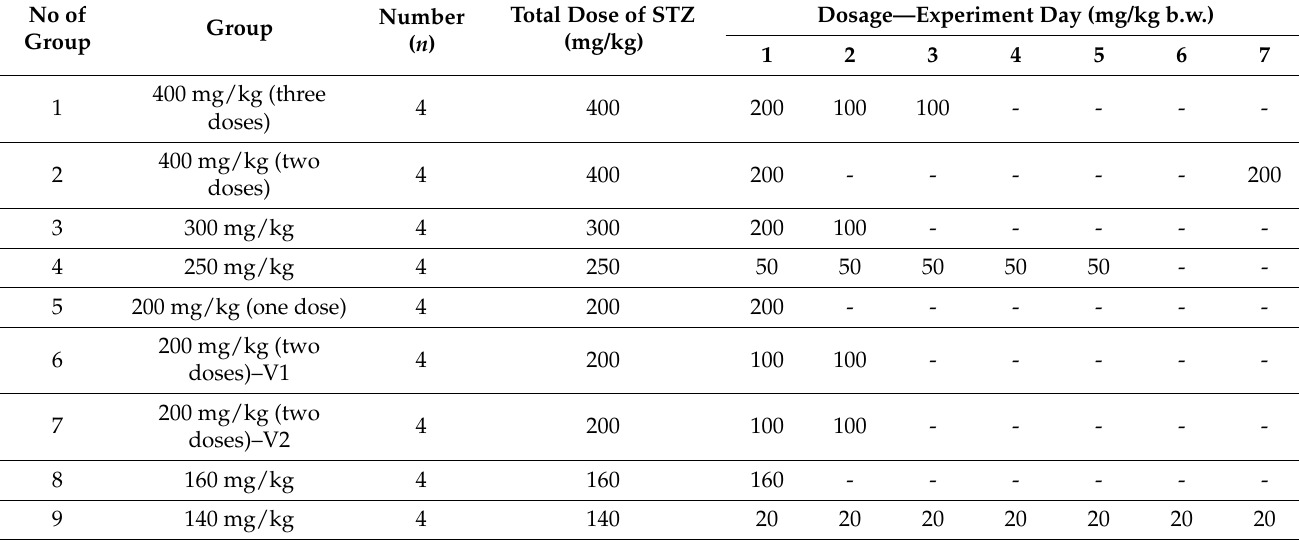
Figure 3. Experimental protocol. The entire experiment was divided into three stages of research. Step 1—assessment of the general health of the animals (bodyweight measurement/C-peptide blood sampling/blood glucose measurement at the experimental checkpoint); division of animals into appropriate groups; STZ injection in mice from the test groups. Step 2—measurement of glycemia and assessment of C-peptide concentration during the 21 days of the study. Step 3—taking the organs for histological analysis. Table 1. Protocol of STZ administration to mice from a given experimental group.